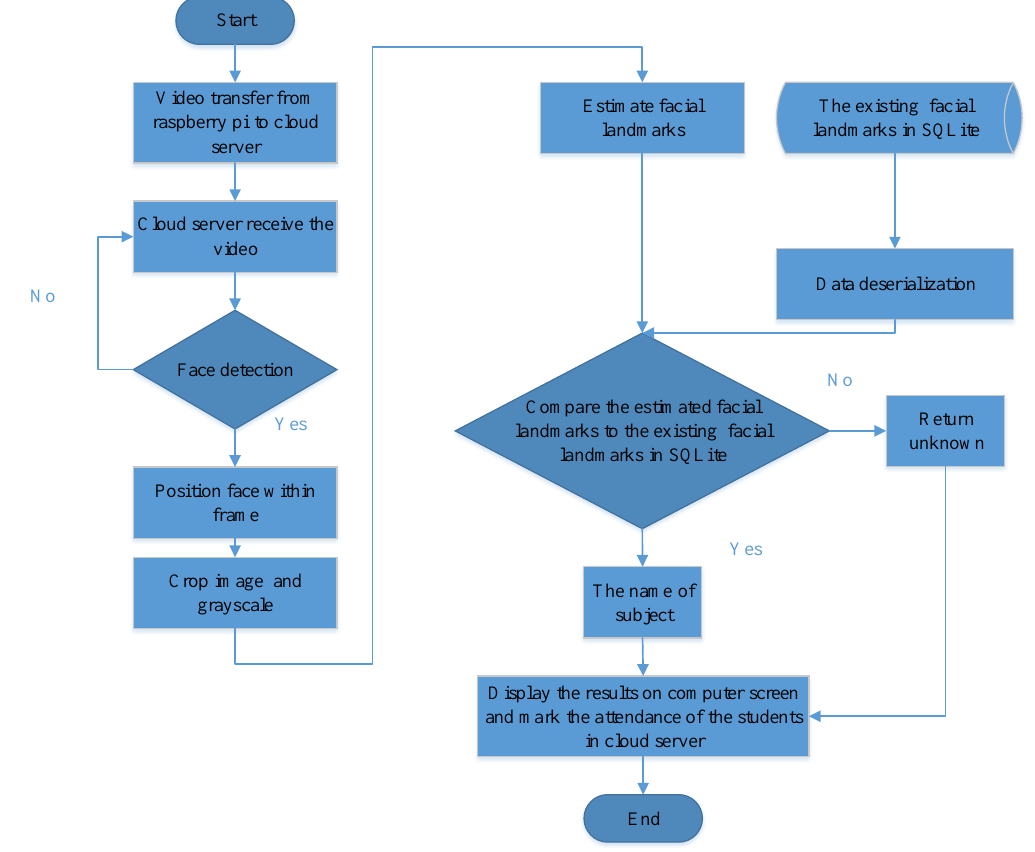
Figure 6. Flowchart of face recognition process.